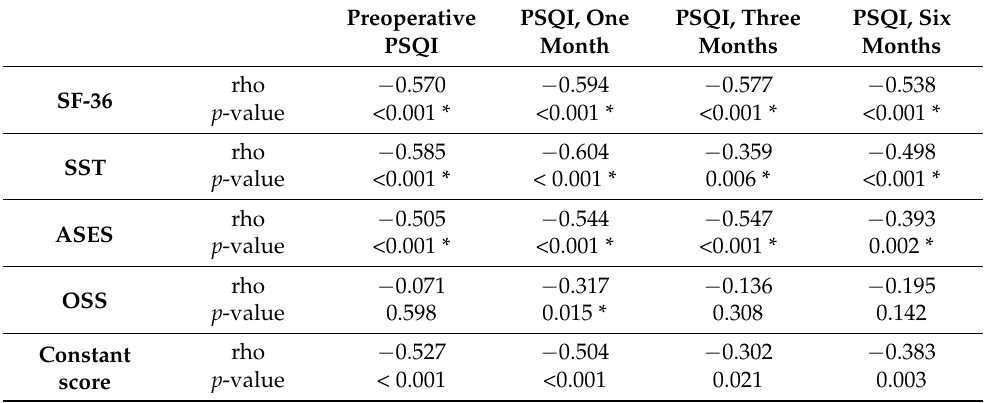
Table 3. Correlation between the PSQI and SF-36, SST, ASES and OSS. Note: (*) = statistically